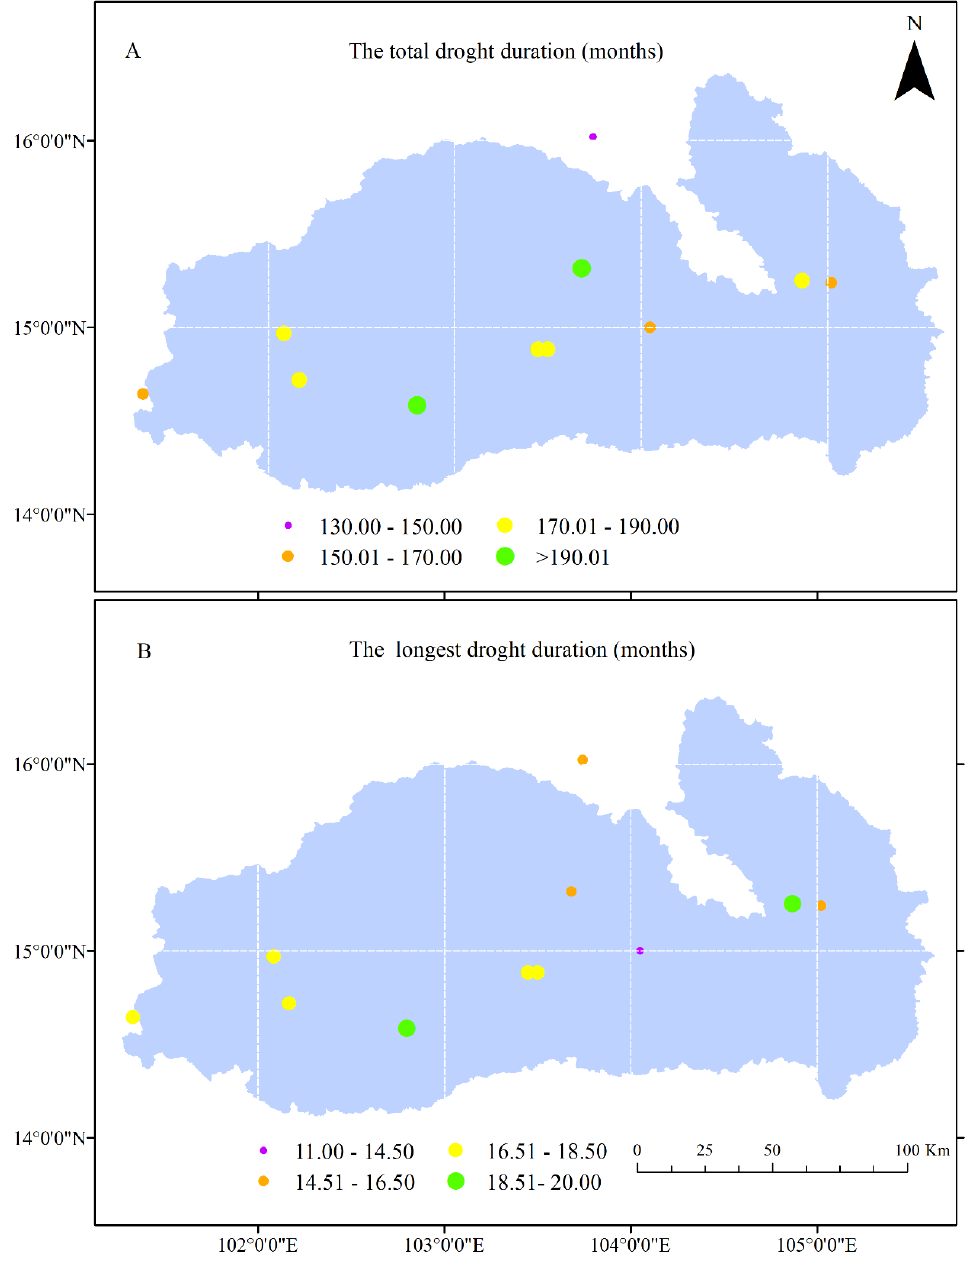
Figure 7. Spatial distribution of ( A ) the total drought duration and ( B ) the longest drought duration during the period of 1971–2016 over the Mun River Basin, Thailand.